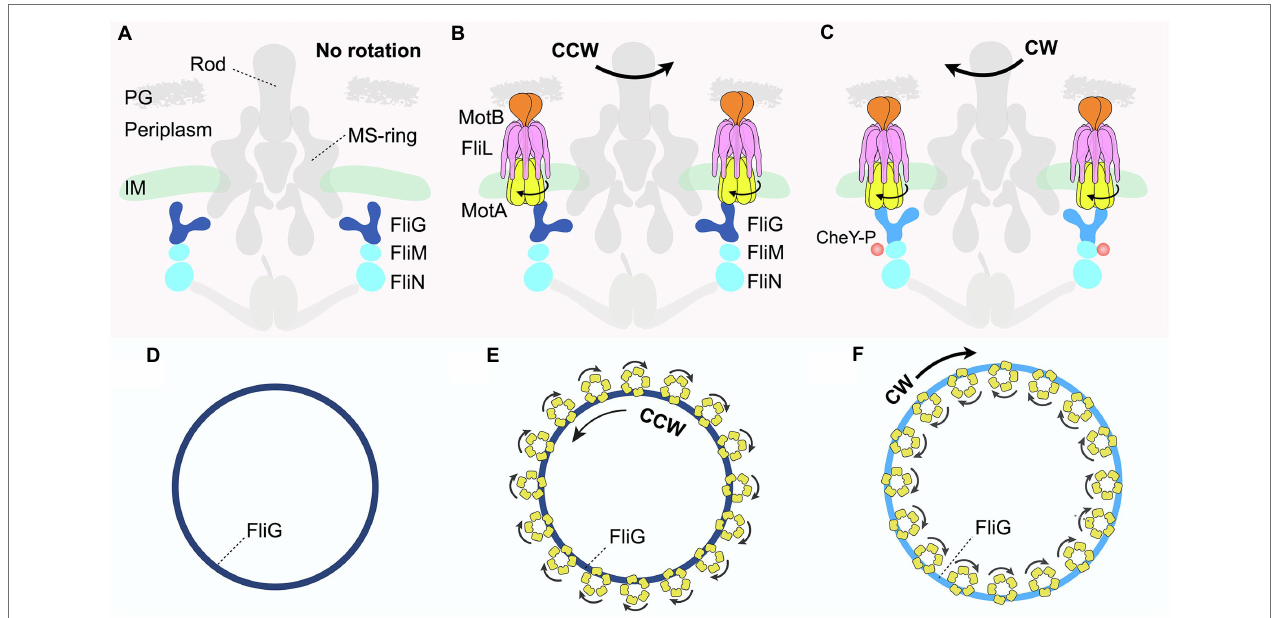
FIGURE 3 | Distinct interactions between the C-ring and stator complexes in response to environmental signals regulate rotational switching of the flagellum. (A,D) Schematic diagrams depicting side and top views, respectively, of the Borrelia burgdorferi periplasmic motor in the absence of the stator complex. (B,E) Schematic diagrams illustrating the side and top views of the B. burgdorferi motor rotating in the CCW direction. The transmembrane FliL is colored pink in (B) . (C,F) Schematic diagrams illustrating the side and top views of the B. burgdorferi motor rotating in the CW direction when bound to a chemotactic protein, CheY-P. The FliG subunit is colored light blue in contrast to dark blue when rotating in the CCW